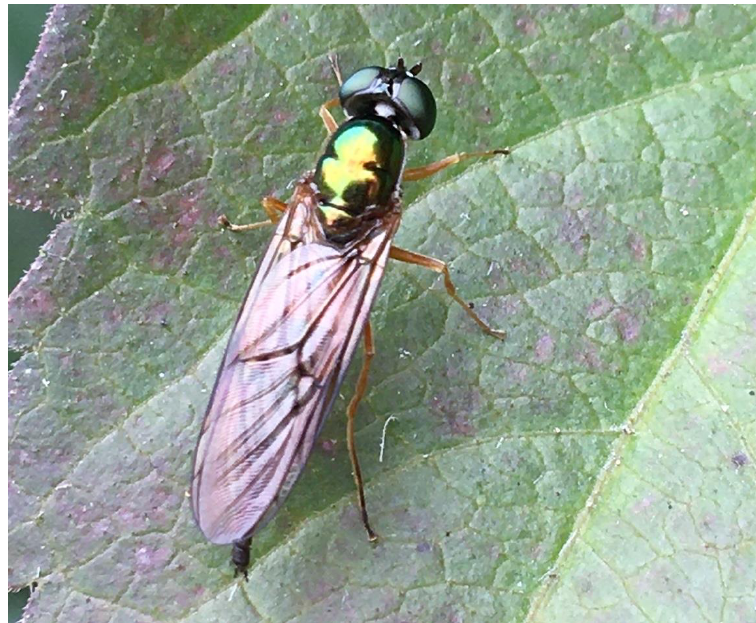
Figure 2. Imago of Sargus bipunctatus . Łódź—Zoo, 1 October 2019. Photo—M. Michalski.